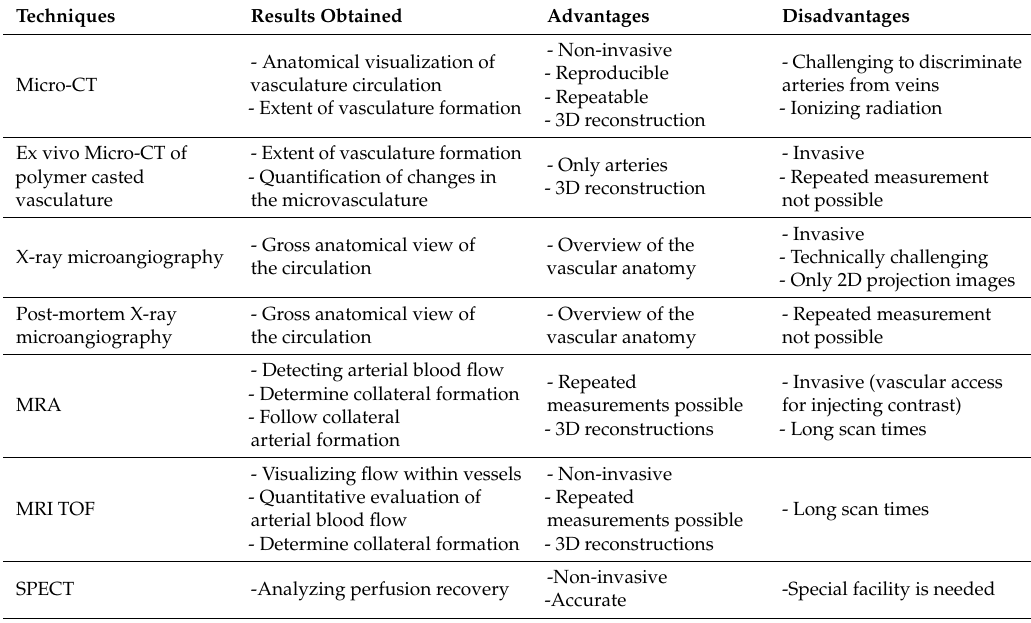
Table 2. Methods of assessment of collateral formation and limb